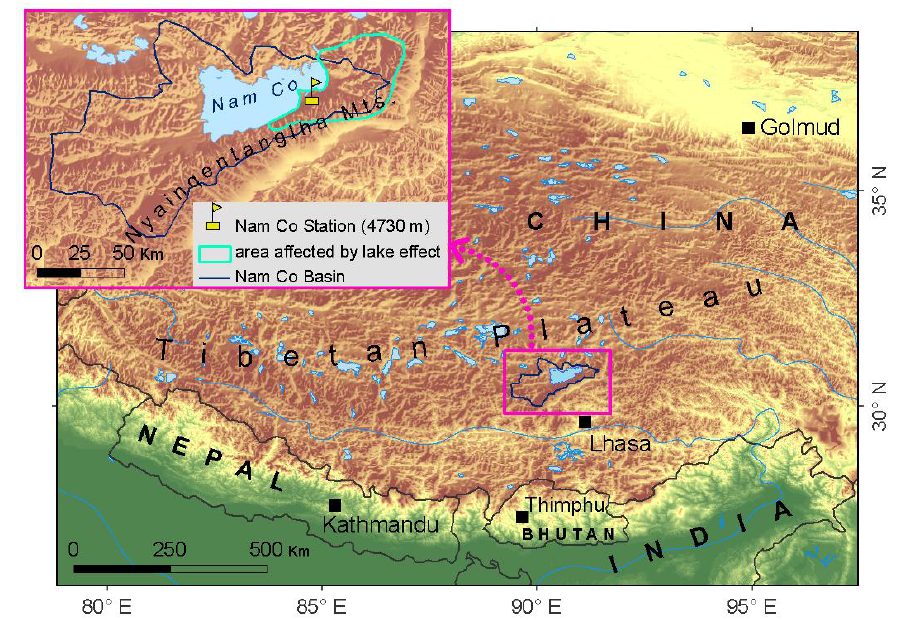
Figure 1. Nam Co basin is located in the center of the Tibetan Plateau. Its altitude ranges from 4,718 m to 7,162 m. The background image is an elevation map based on the SRTM and GTOPO30 digital elevation